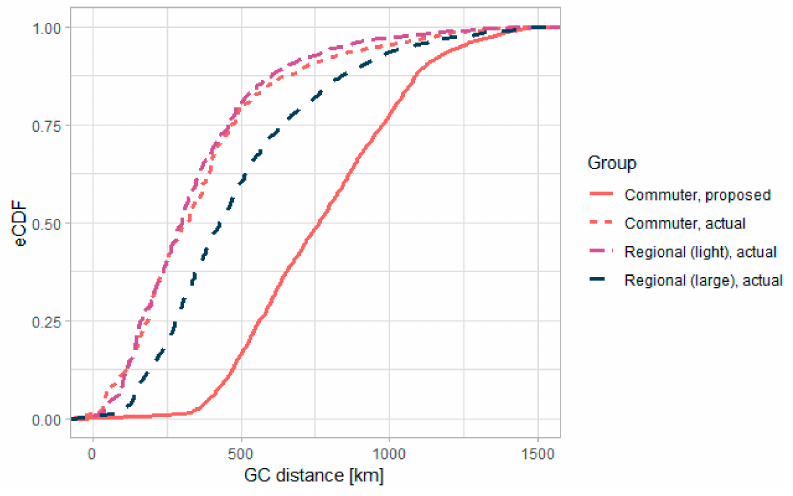
Figure 5. Aggregated distribution of flight segments for the proposed commuter